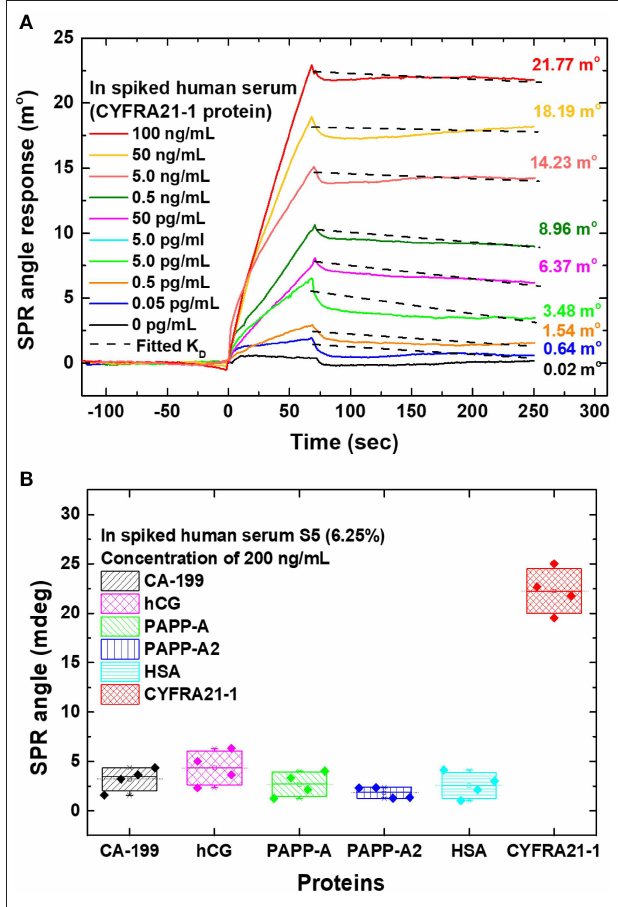
FIGURE 14 | Synthesis of MoS 2 -COOH sheet with monocholoroacetic acid (MCA). Figure was reproduced from Chiu et al. (2018) with permission from Elsevier. Copyright 2018, Elsevier.